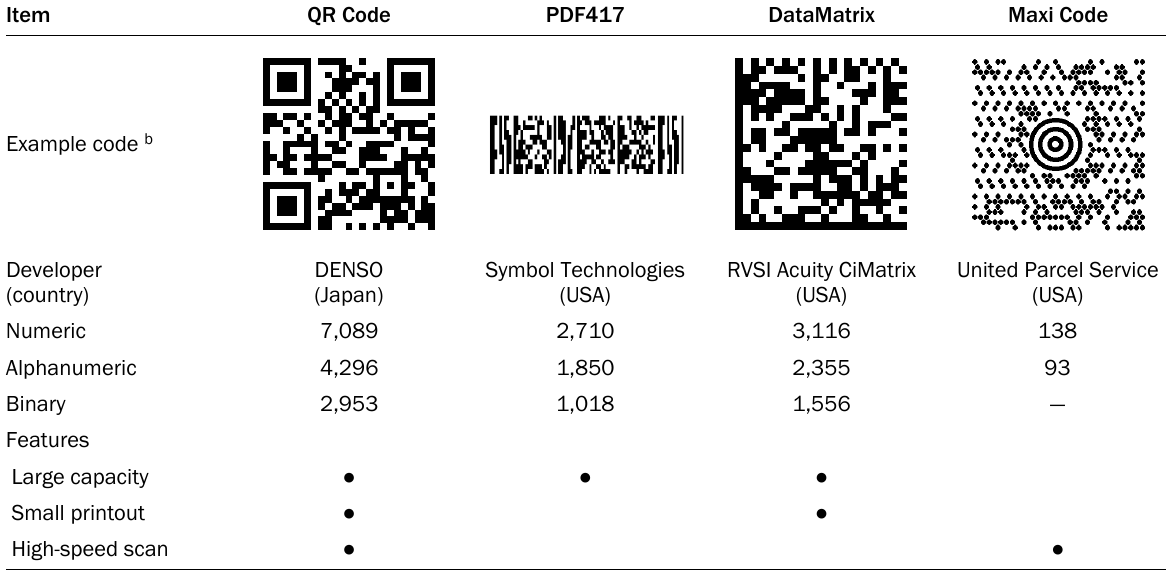
Table 1. Examples of 2D Barcode Symbologies, Capacities, and Distinguishing Features